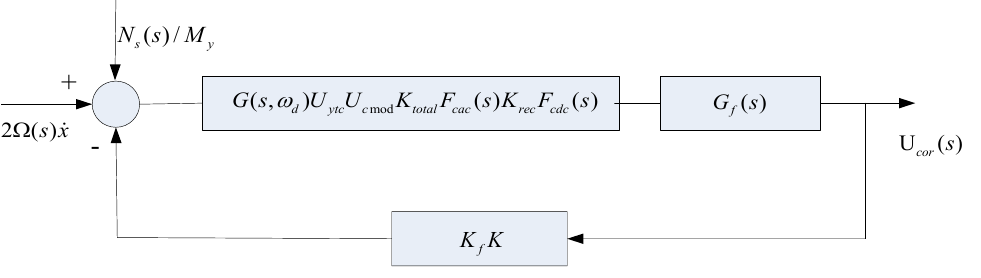
Figure 6. The simplified block diagram of coriolis signal closed-loop detection.